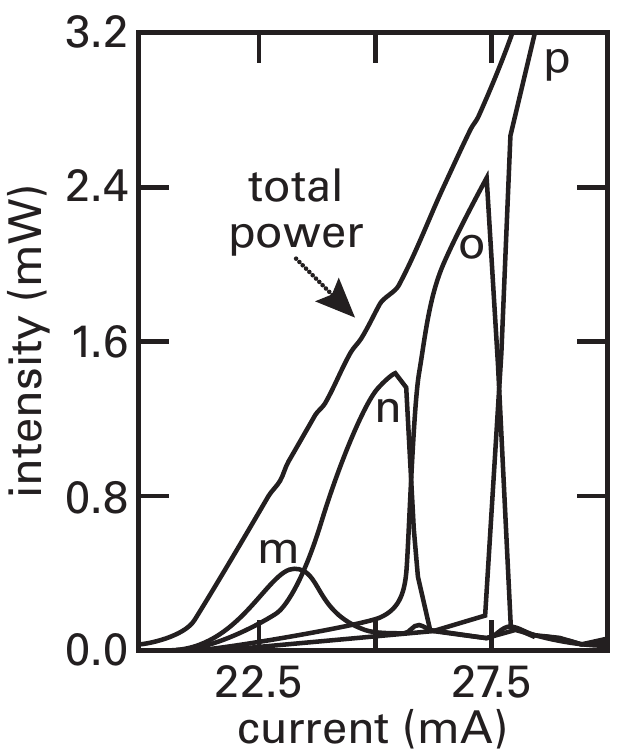
Figure 3. Experimental data. The lower case letters m, n, o, and p are labels for the four dominant modes shown in this figure and in Figure 4. Adapted from Figure 3 of [7].